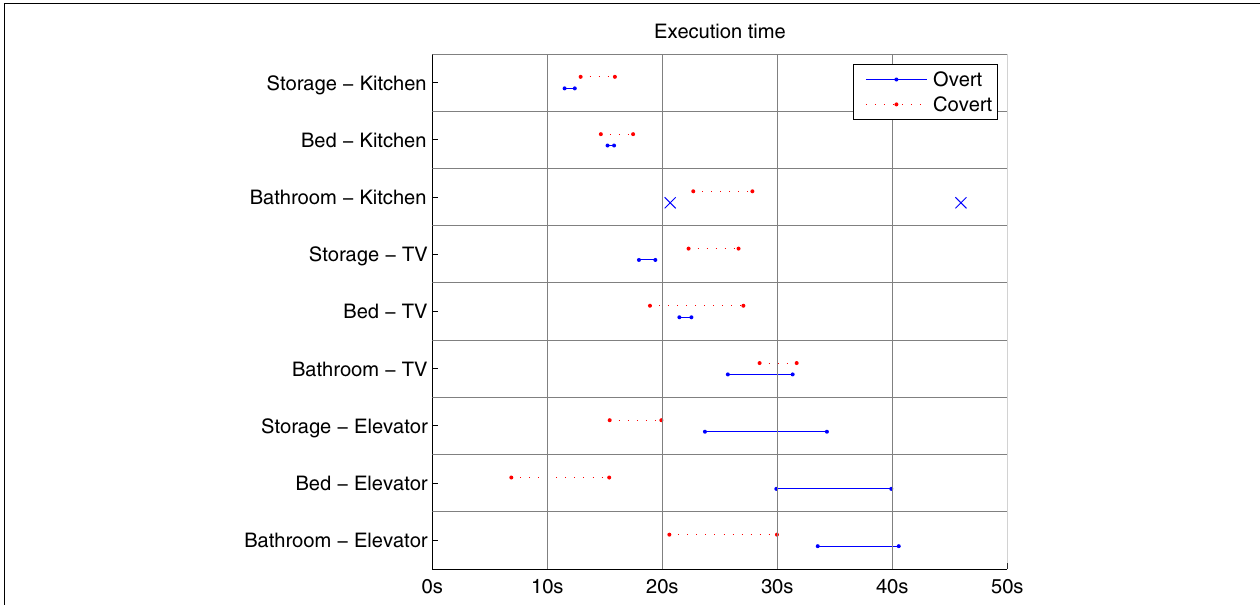
FIGURE 9 | Execution time, i.e., time to reach the goal, from all successful runs in each condition . Solid and dashed lines represent the 95% confidence interval of the means of overt and covert runs, respectively. Conditions with few successful runs are displayed as (cid:2) marking execution times for individual runs, rather than a distribution.